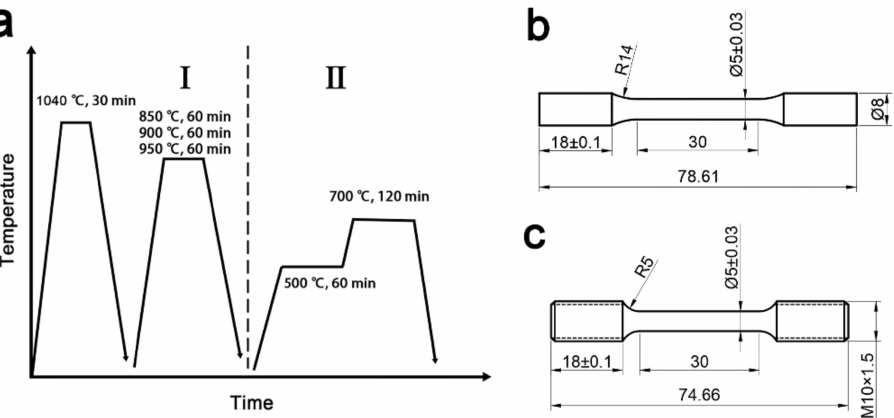
Figure 2. The schematic diagrams of ( a ) heat treatment, ( b ) room temperature, and ( c ) high-temperature tension size